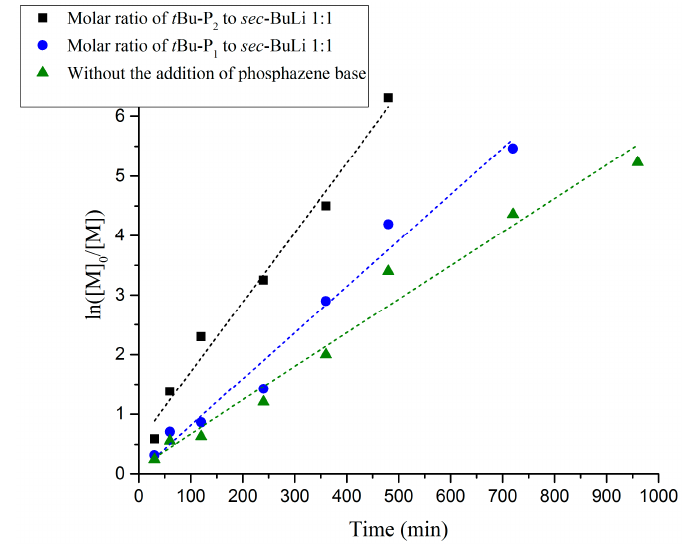
Figure 5. Kinetic plots of anionic polymerization of 1,3-butadiene in the presence of t -BuP 2 , t -BuP 1 and in the absence of phosphazene base.